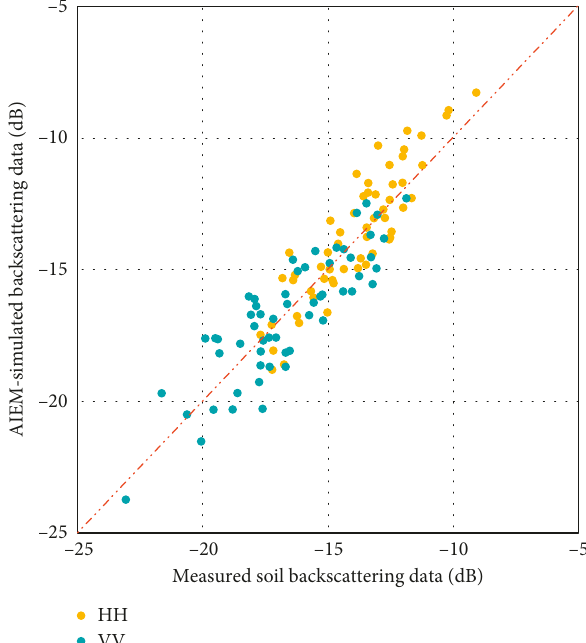
Figure 7: Scatterplot of AIEM-simulated backscattering data ) and GF-3-measured soil backscattering data ( σ ° ( σ ° soil − simu calculated using the